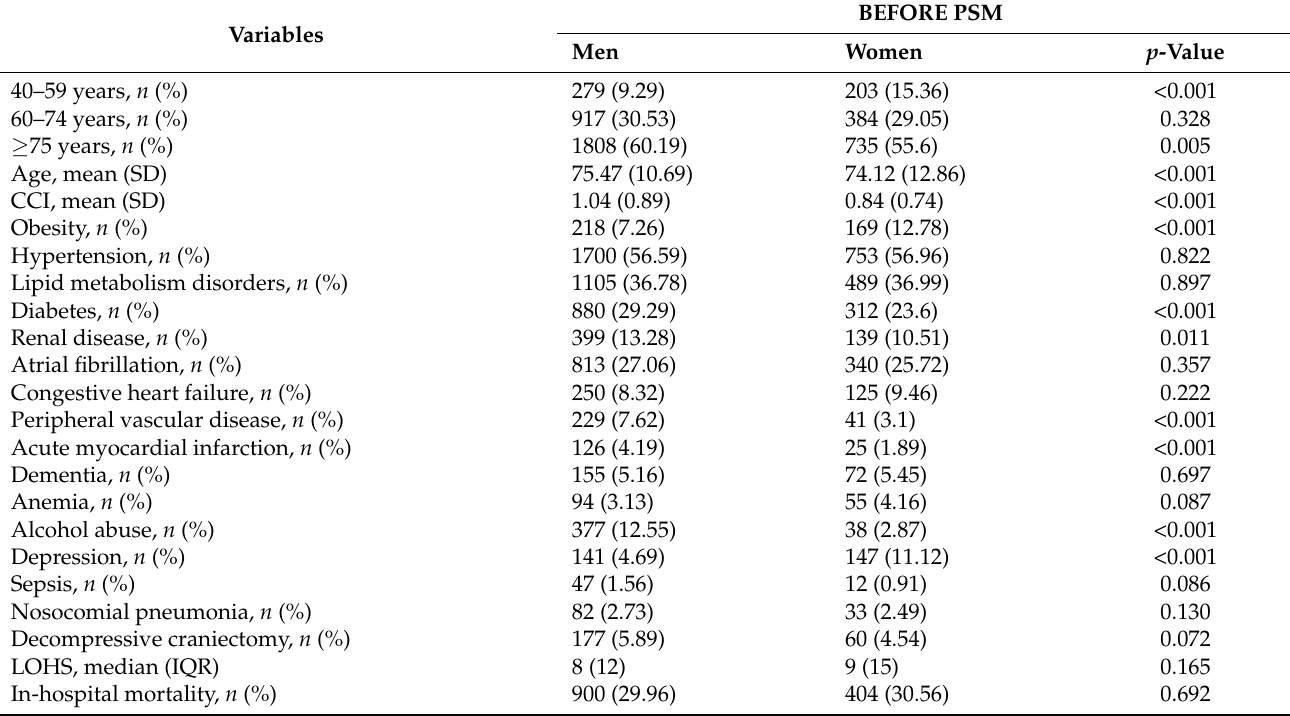
Table 4. Clinical characteristics, use of therapeutic procedures, and hospital outcomes before propensity score matching among COPD patients with HS according to